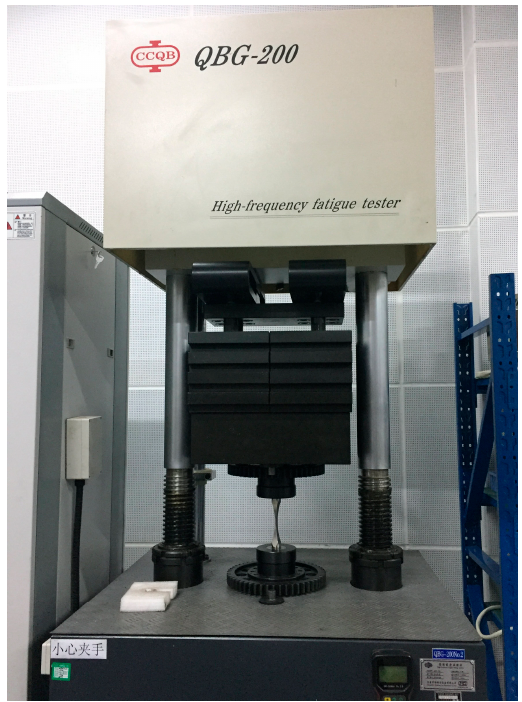
Figure 6. Setup of the fatigue experiments.